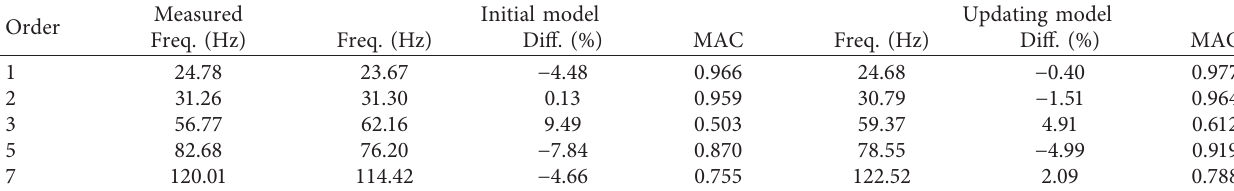
Table 6: Comparison of modal data before and after model updating.